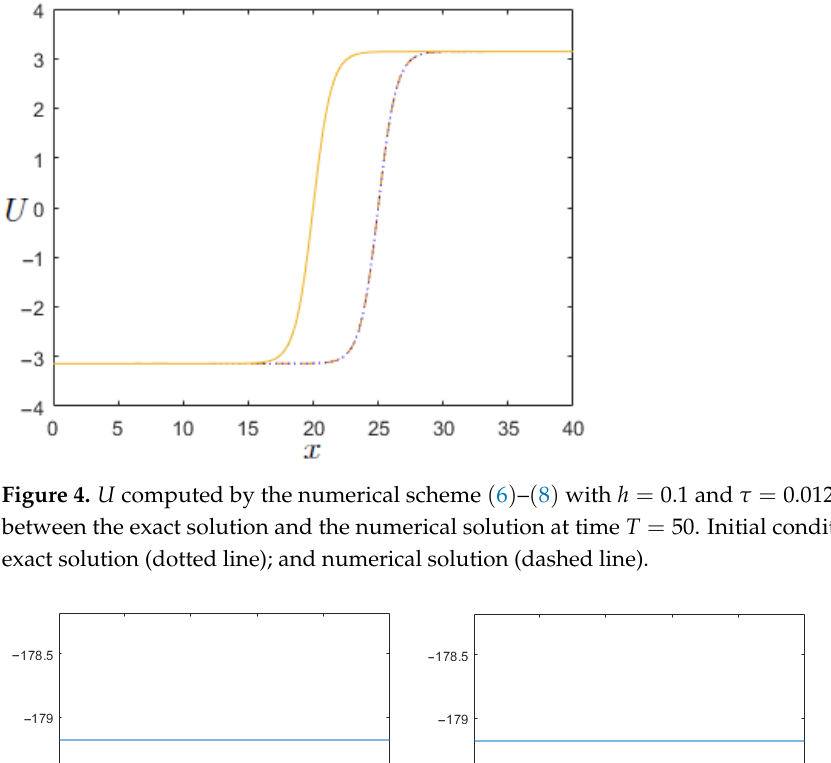
Figure 5. Discrete energy E n and discrete quantities ˜ E n , Q n , and (cid:107) U n scheme ( 6 ) – ( 8 ) with h = 0.1 and τ = 0.0125 at time T = 50. E n ( Up-Left ); ˜ E n ( Up-Right ); Q n (cid:107) 2 ( Down-Right ( Down-Left ); and (cid:107) U n t